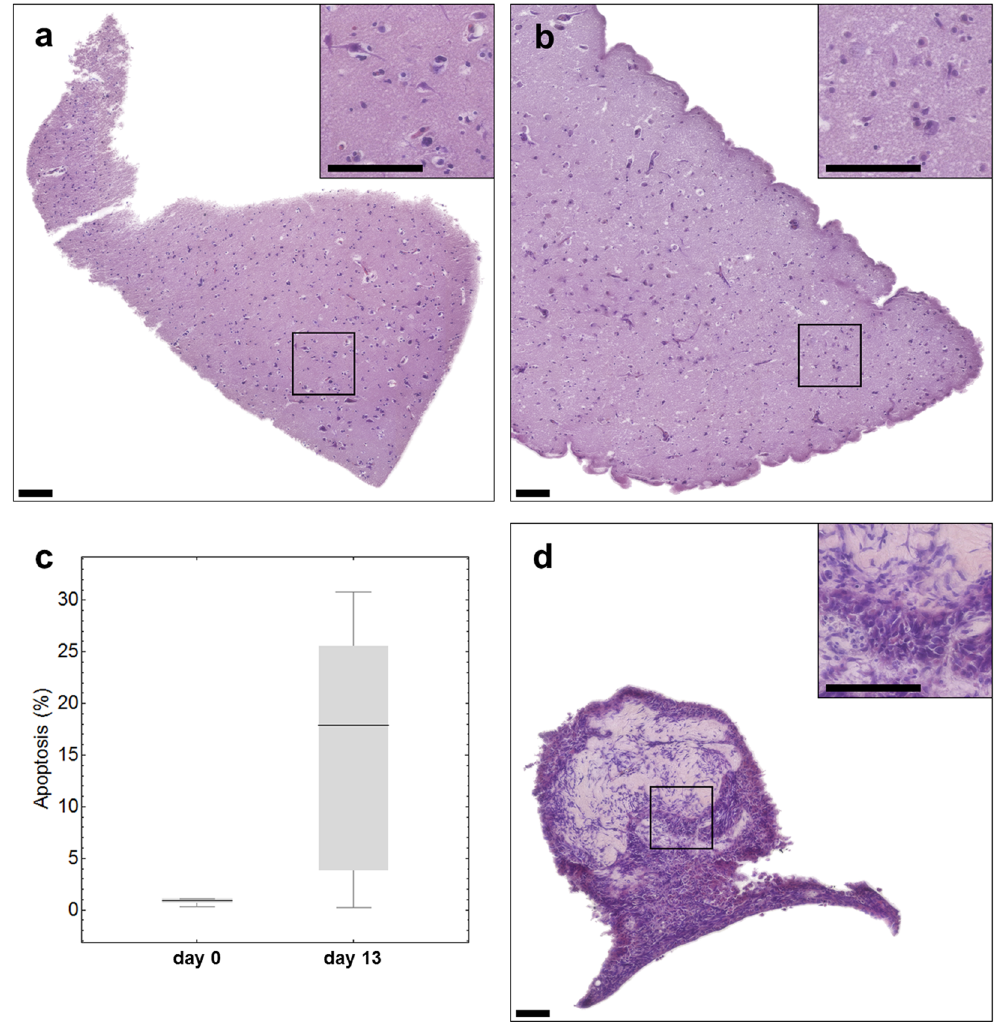
Figure 1. Histology of freshly sliced ( a ) or cultivated ( b ) tumor-surrounding brain tissue (peritumoral tissue of zone III) and cultivated GBM tissue ( d ). Hematoxylin (nuclei) and eosin (cytoplasm) staining was done ( a ) instantly after the slicing procedure or after 13 days in culture ( b,d ). Apoptosis rate was determined by TUNEL staining in peritumoral tissue on day 0 (left bar) and day 13 (right bar) ( c ). Scale bar: 100 µ